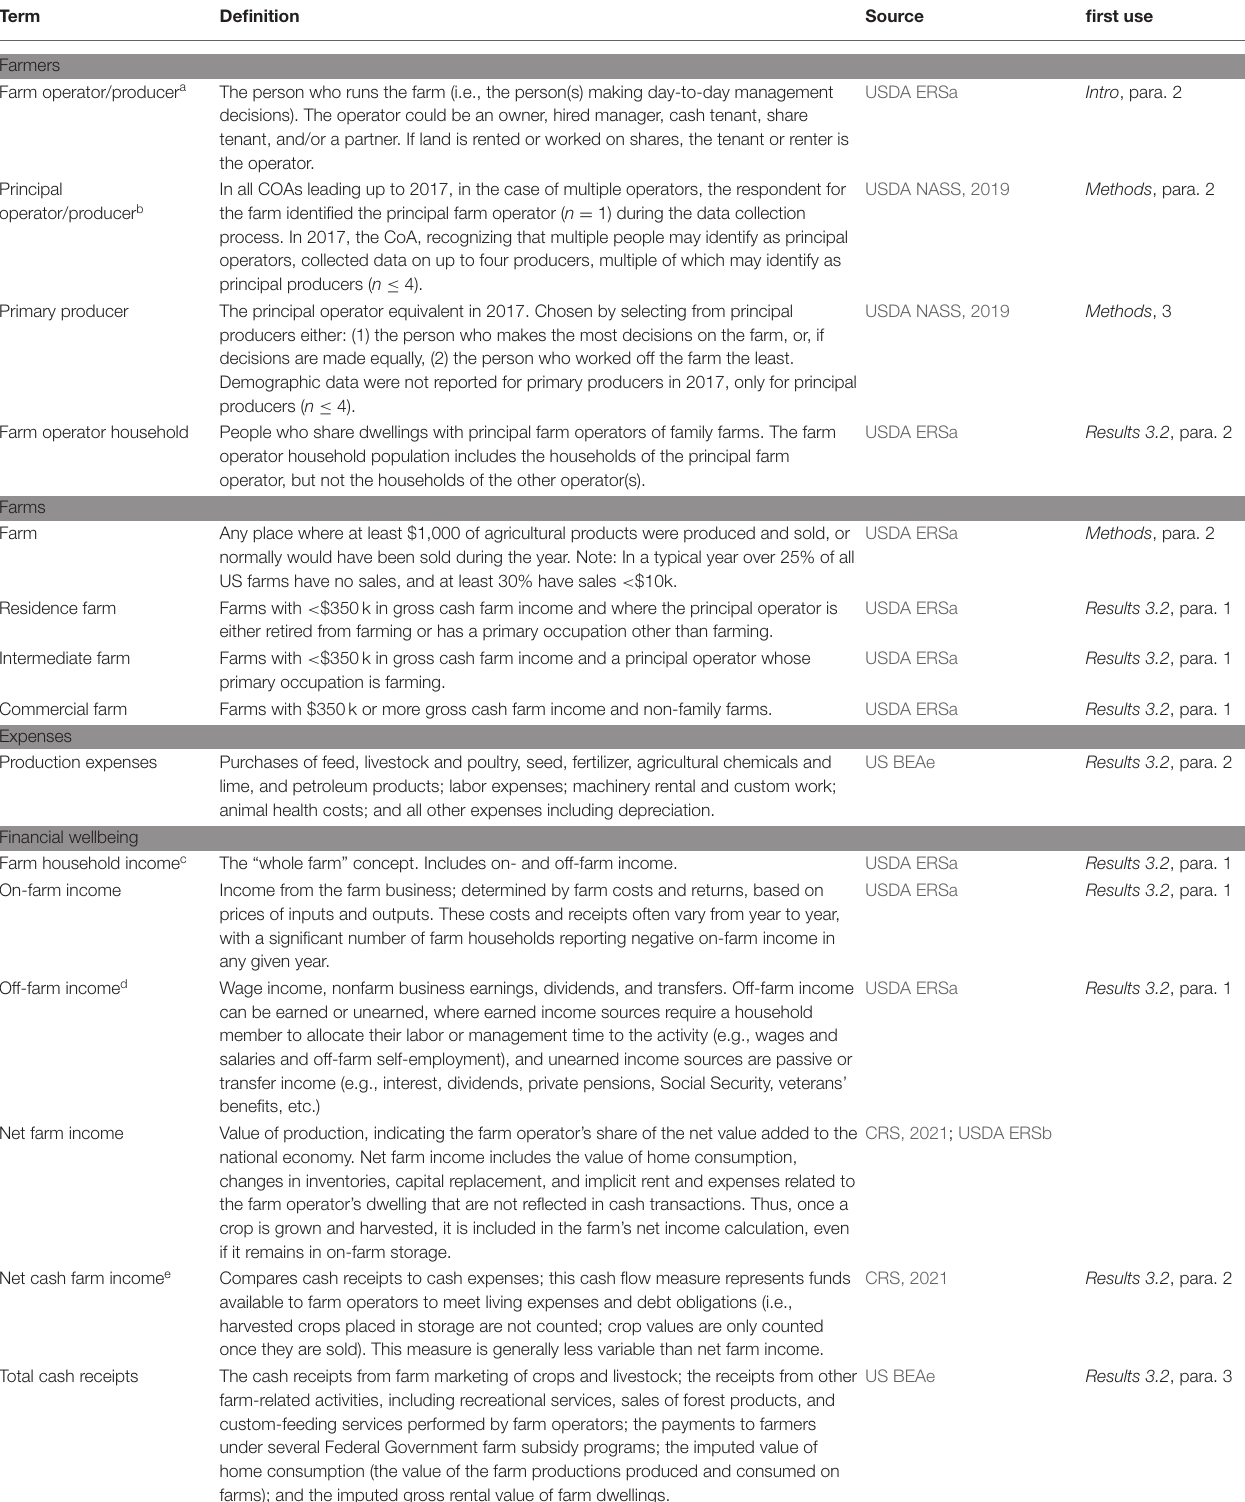
TABLE 1 | Commonly used terms, definitions, and